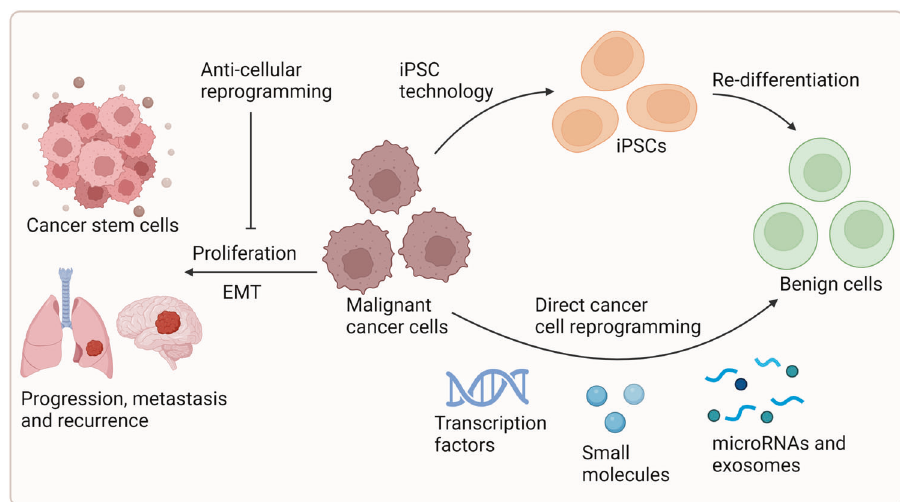
Fig. 6 The mechanisms for cellular reprogramming in cancer. Cancer cell reprogramming treatment aims to convert the malignancy to benignity or provide a therapeutic target to inhibit the formation of CSCs. Yamanaka factors-mediated iPSCs technology has been recognized as a common method for the conversion of cancer cells to benign pluripotent cells, and cancer cells-derived iPSCs can re-differentiate into functional cells with less malignancy and free of tumorigenic potential. Cancer cells also can be directly reprogrammed into benign cells via various reprogramming strategies, such as lineage-speci fi c factors, small molecules, microRNAs, and exosomes. Responsive cellular reprogramming based on EMT contributes to CSCs formation, which mediates the initial, progression, metastasis, and post-treatment recurrence. The role of cellular reprogramming in the formation of CSCs suggests that anti-cellular reprogramming strategies may be considered as a therapeutic alternative in cancer treatment. EMT Epithelial – mesenchymal transition. Created with